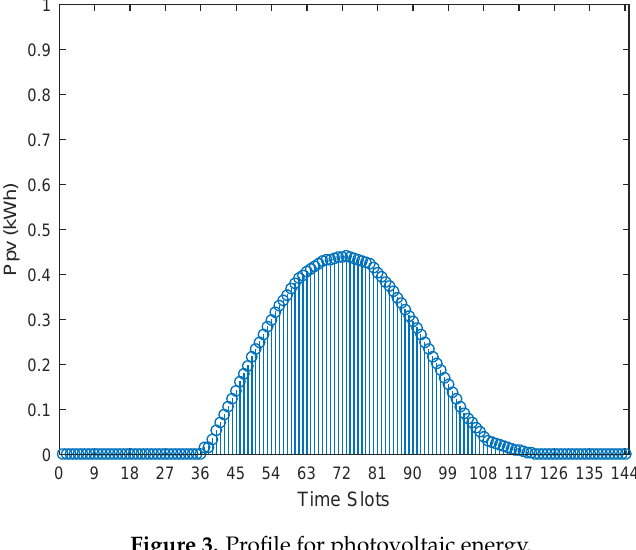
Figure 3. Profile for photovoltaic energy. Table 7. Photovoltaic system specifications.